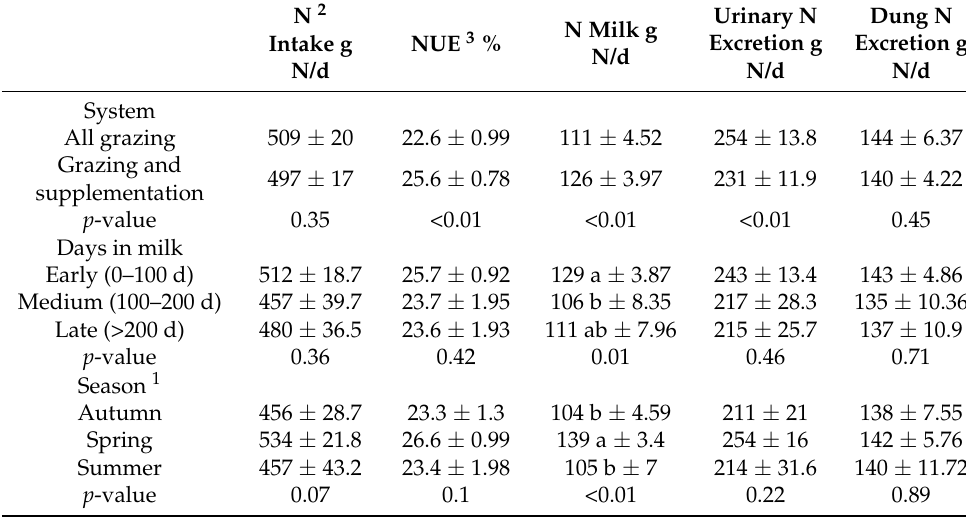
Table 5. Effect on system, stage of lactation and season on nitrogen partitioning of Chilean dairy cattle (mean ± standard error).